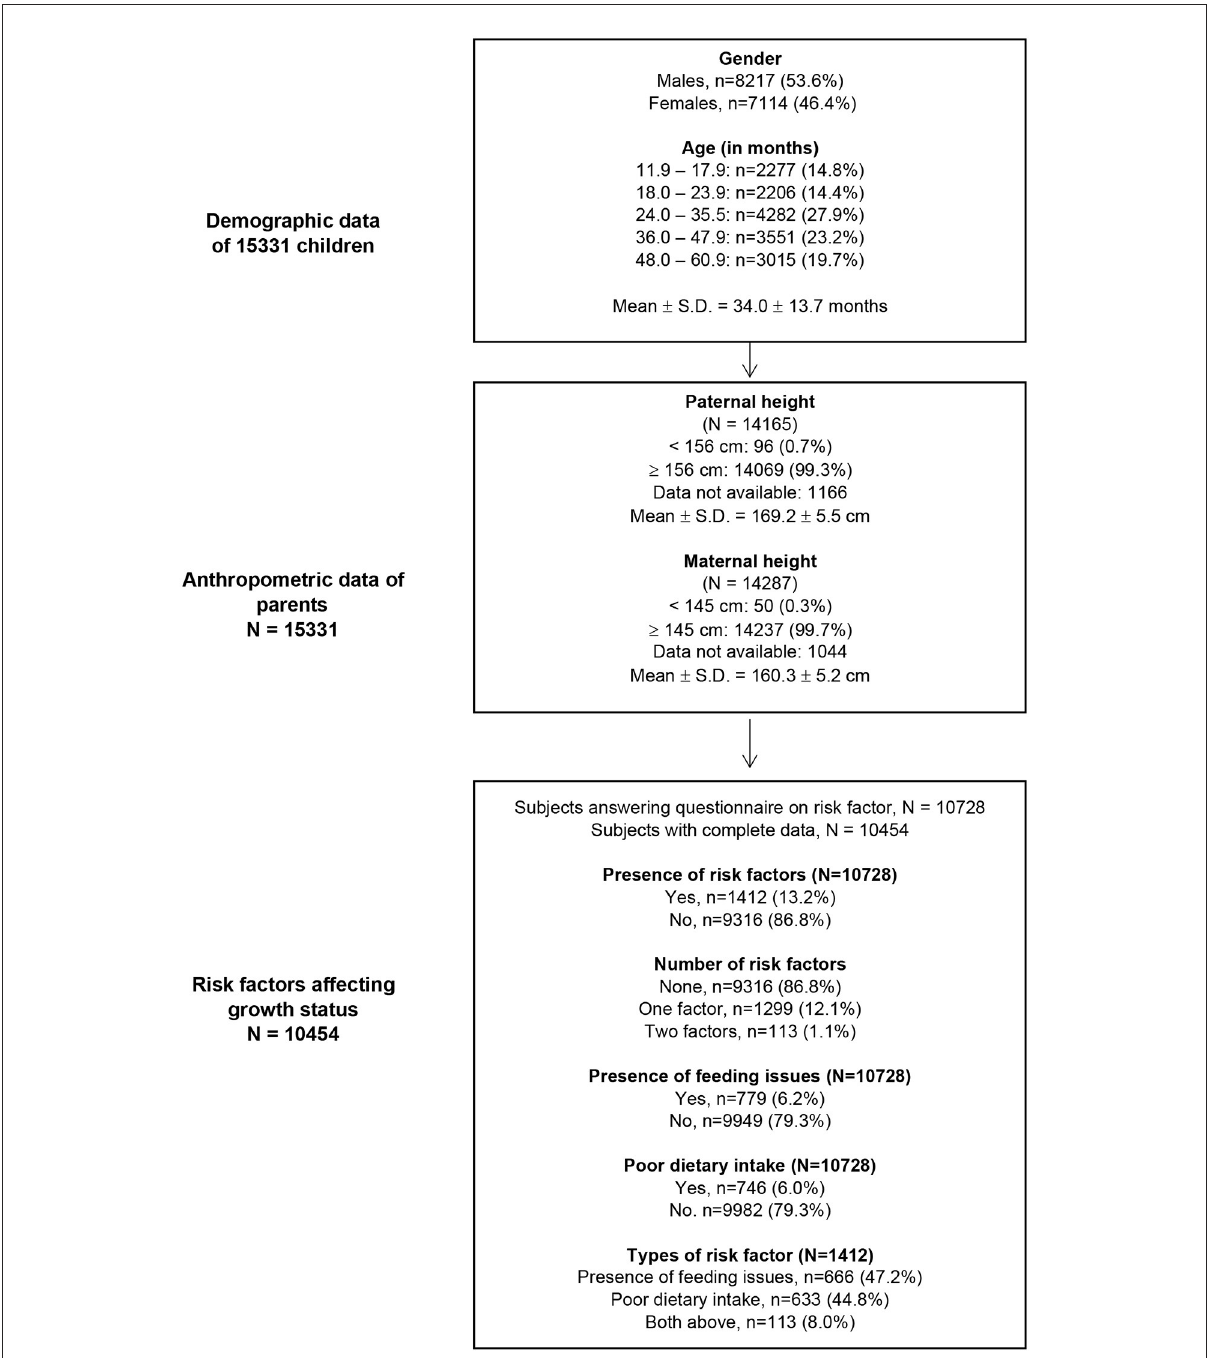
FIGURE1 Demography, anthropometric data, and risk factors affecting growth status in Malaysian children aged 1 to 5